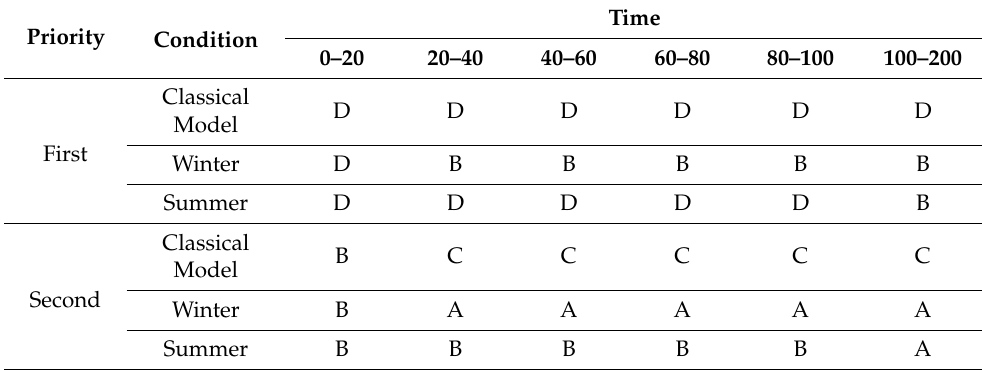
Figure 8. The results reliability importance measure in the summer reliability. Table 9. The priority ranking of components in 200 h operation